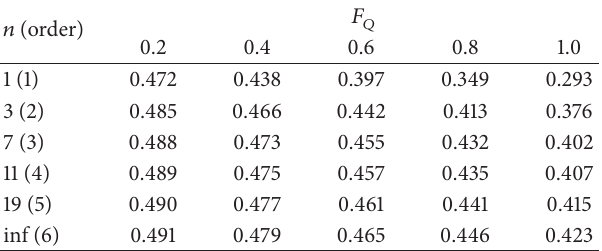
Table 1: Values of 𝐹 𝑄 as a function of 𝐹 𝑄 and 𝑛 when solving (9). 𝑑